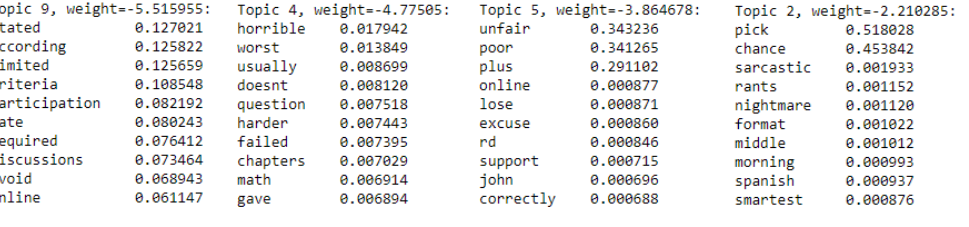
Figure 8. Topics with negative θ − weights. The θ − weight is given as the topic weight. The strength of each word is given numerically beside each of the top 10